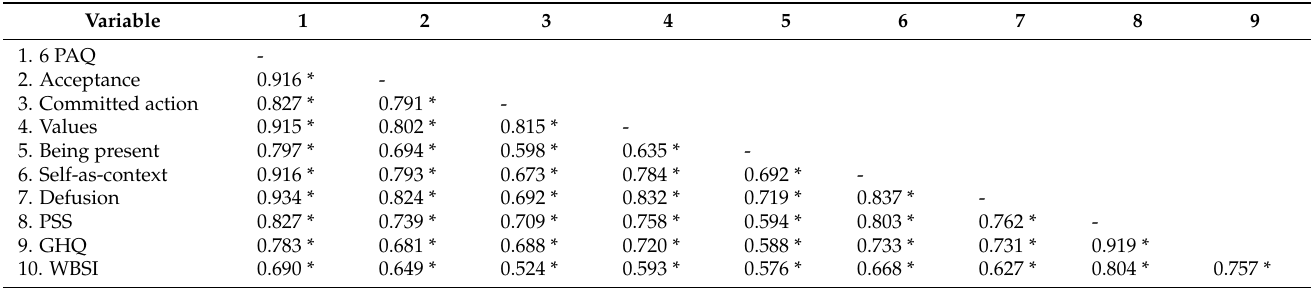
Table 5. Correlational Matrix: 6-PAQ, PSS, GHQ y WBSI for the whole sample ( n = 151).